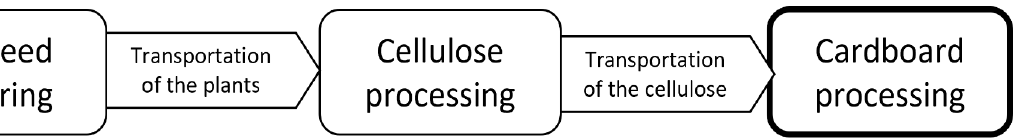
Figure 5. Business- model ‘ processing plant’. Bold contour highlights processes performed by other Figure 5. Business-model ‘processing plant’. Bold contour highlights processes performed by other organizations (contractors, consumers, etc). organizations (contractors, consumers,